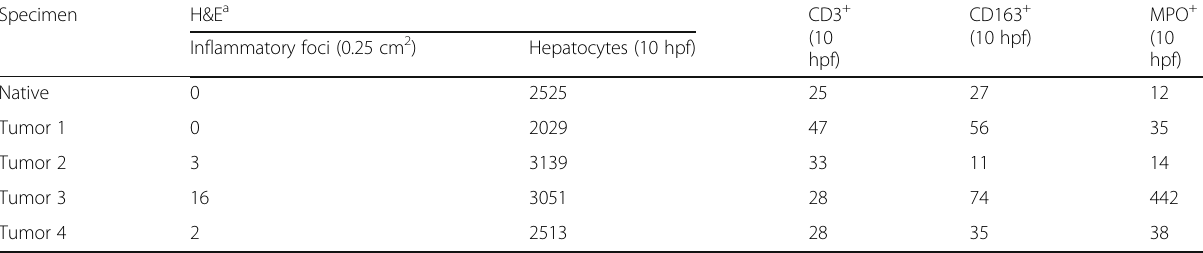
Table 4 Histopathology of liver parenchyma derived from healthy (native) and tumor-bearing rats, respectively